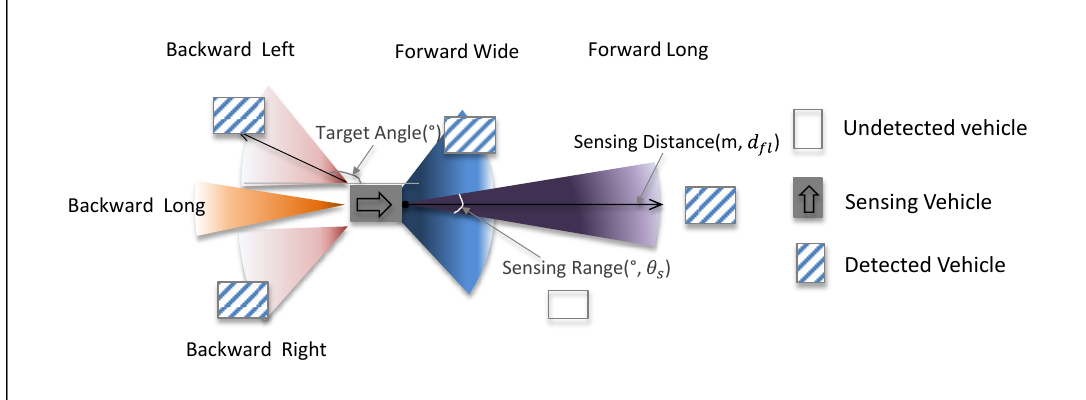
Figure 1. Sensing vehicle and its sensing range specifications.